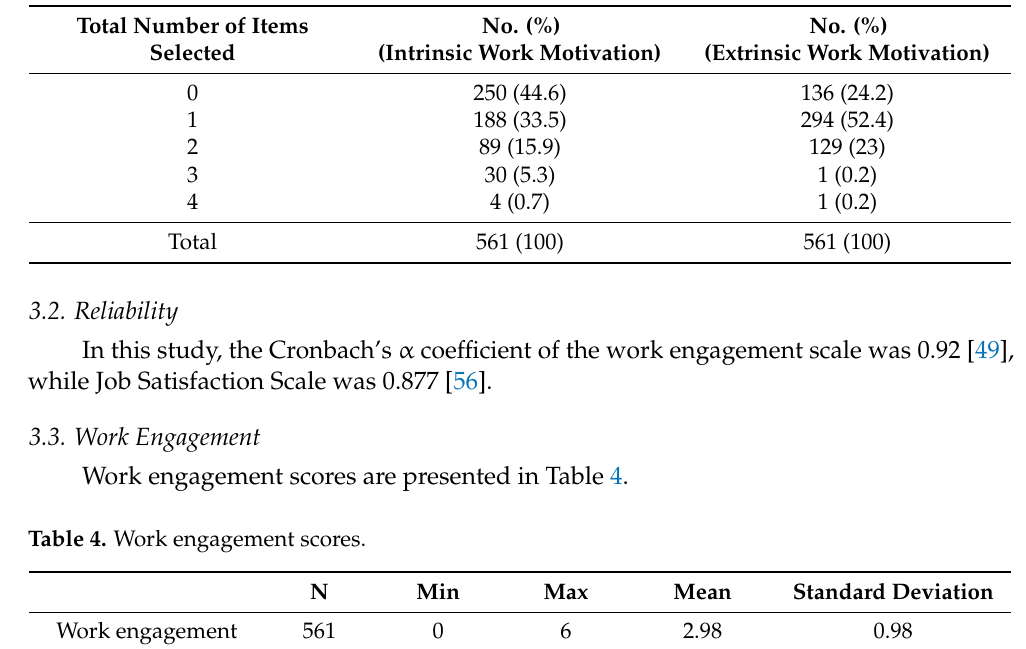
Table 3. Number of intrinsic and extrinsic work motivation items selected: Frequency and proportion of participants.